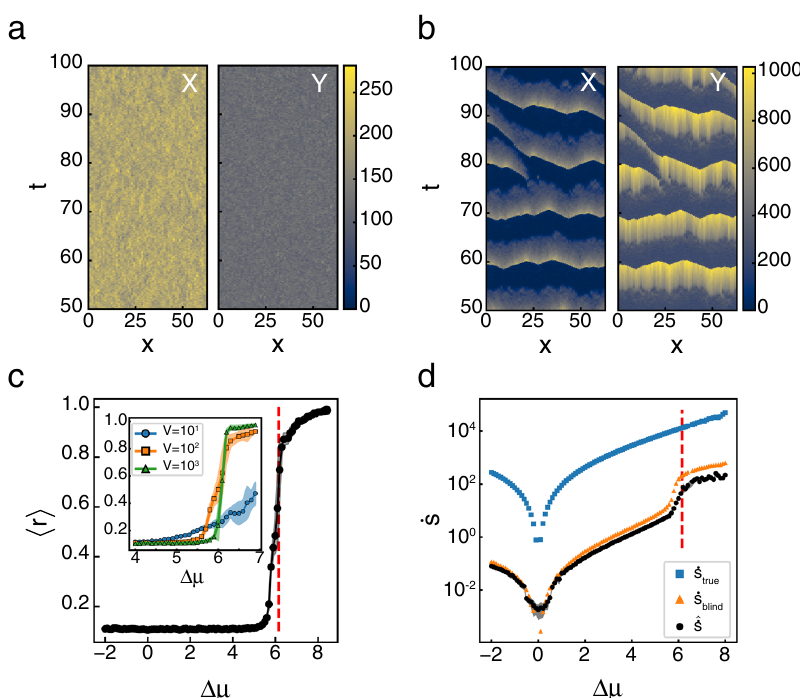
Fig. 4 Reaction-diffusion Brusselator synchronizes above Hopf bifurcation. a Subsection of a typical trajectory for X ( x , t ) and Y ( x , t ) for a Δ μ = 3.5, below the Hopf Bifurcation and b Δ μ = 6.2, above it. Color indicates the local number of the chemical species. c Synchronization order parameter, 〈 r 〉 , as a function of Δ μ . Vertical red dashed line indicates Δ μ HB . Inset shows the same measurement for volumes V = {10 1 , 10 2 , 10 3 } shown by blue circles, orange squares, and green triangles, respectively, at each lattice site over a smaller region of Δ μ . Dots and shaded areas show mean ± s.d. of N = 10 simulations. d _ s as a function of Δ μ . Blue squares, orange triangles, and black circles show results for _ s true , _ s blind , and ^_ s , respectively. Shaded area shows mean ± s.d. of N = 10 simulations. Vertical dashed red line indicates Δ μ HB . See Supplementary Tables 3 and 4 for all simulation parameters.